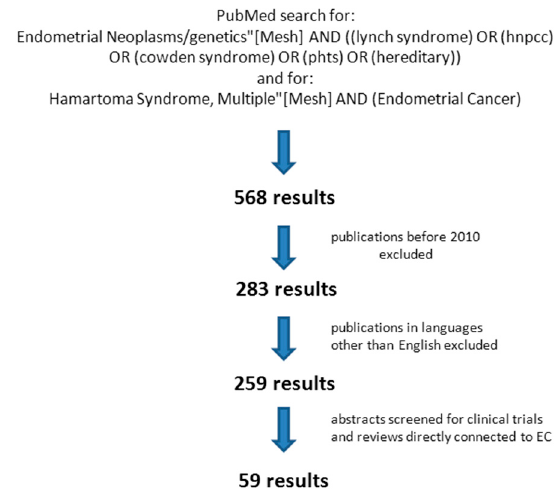
Figure 2. PubMed search strategy.